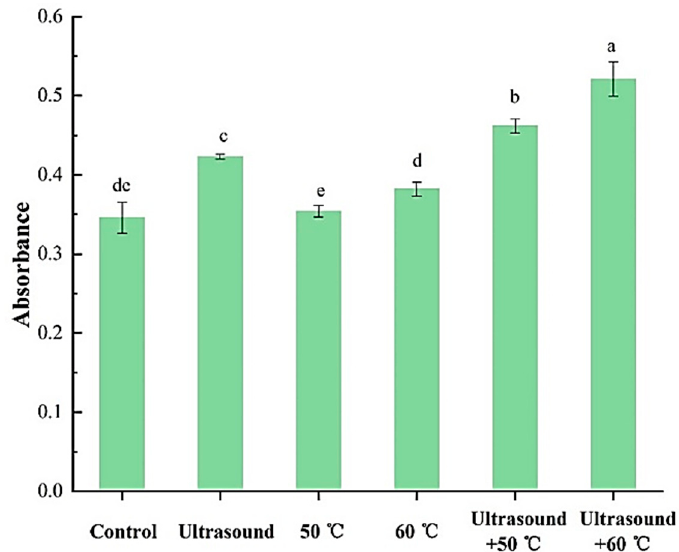
Figure 5. Effects of ultrasound with or without mild heating treatments on the flexibility of 11S globulin ( p < 0.05, RM ANOVA, Duncan test).